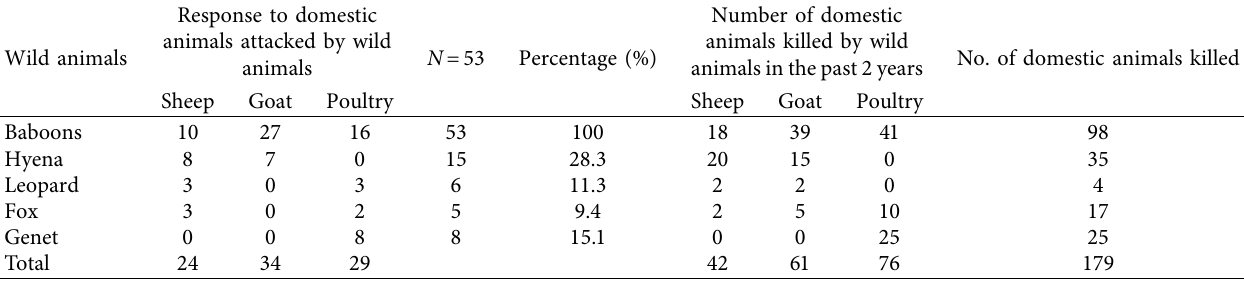
Table 9: Livestock attacks and predation by wild animals.